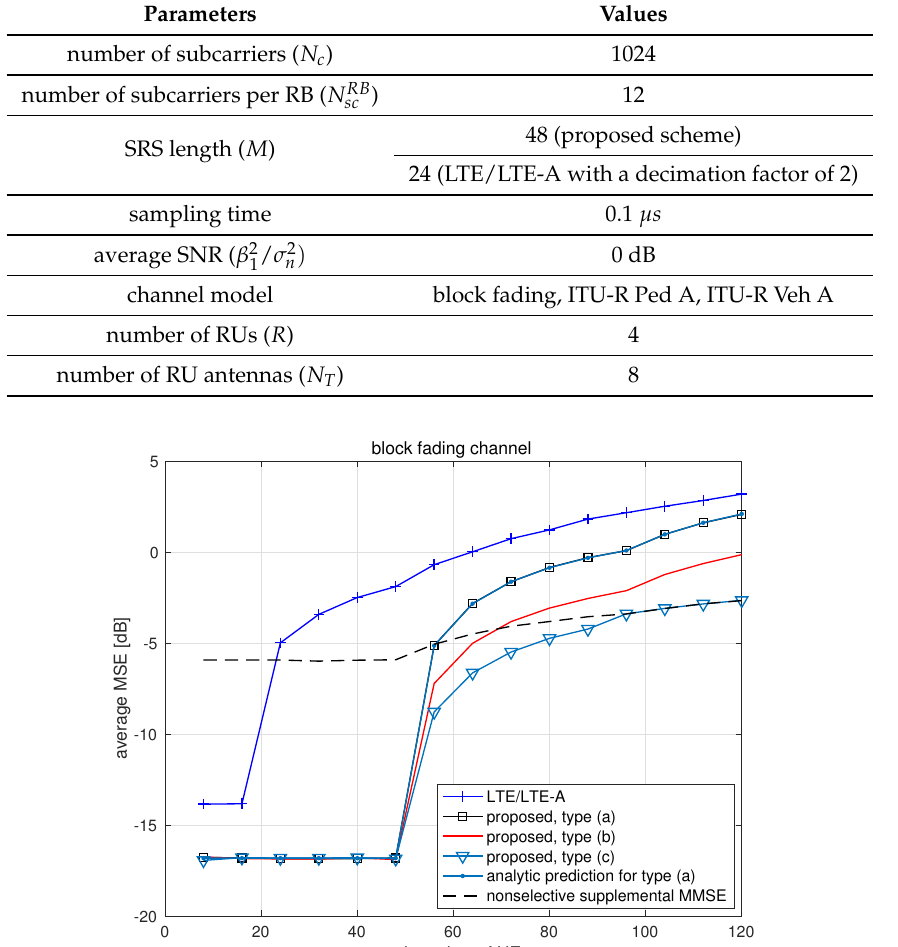
Table 1. Parameters used in performance evaluation.